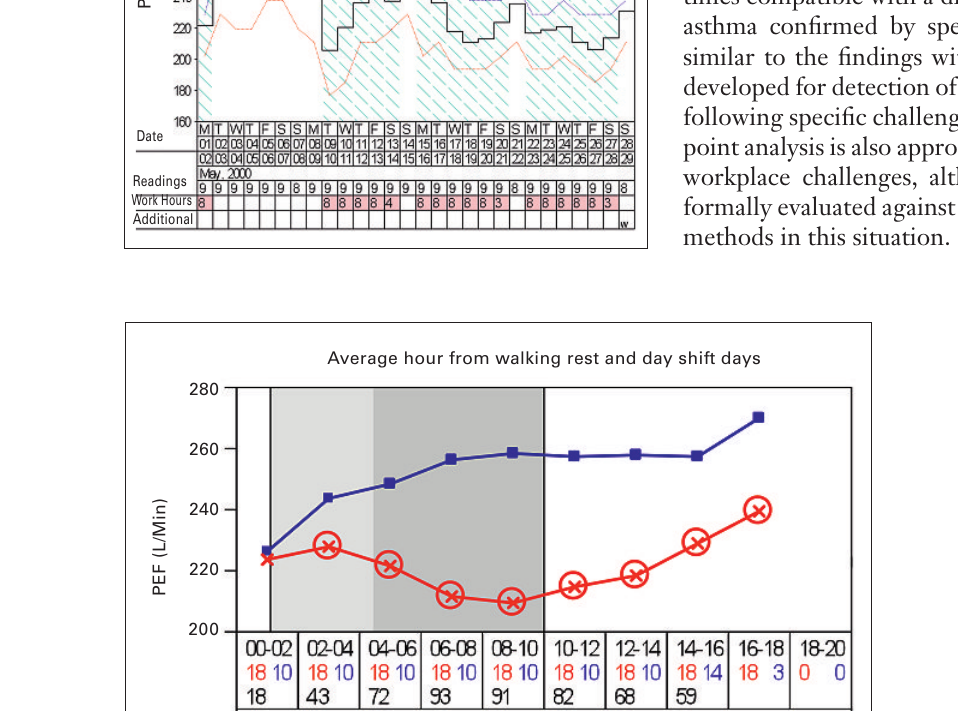
Oasys plot of 2-hourly PEF in a plastic moulder sensitised to formaldehyde.The middle panel shows the daily maximum (upper dotted line), mean (middle solid bars) and minimum (lower dotted line). Days at work have a shaded background, days away from work a clear background. The PEF is low (predicted 537, top dotted line), the Oasys discriminant analysis score is 3.14 (scores over 2.5 are significant), but the changes are relatively small.